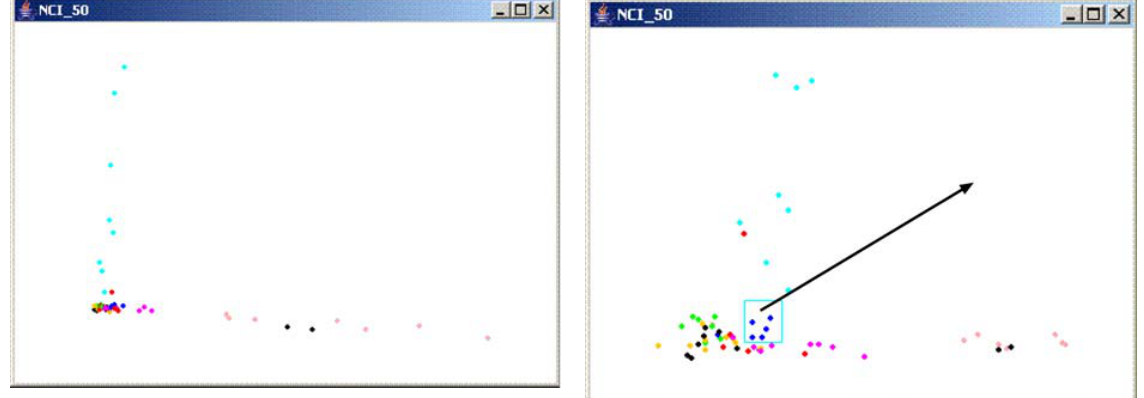
Figure 3.1: Prototype Tool Interface: the initial view of the chosen data set showing the first two principal components.